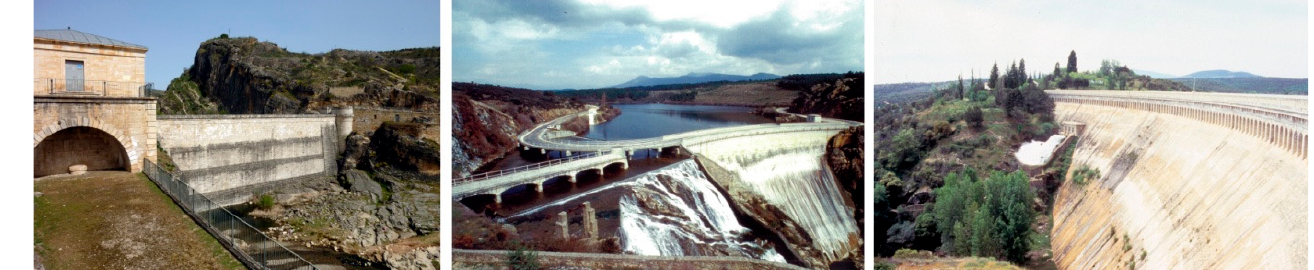
Figure 5. Pontón de La Oliva (1858–1860): straight solid masonry gravity-based dam and narrow- lipped spillway. Villar Dam (1869–1882) Engineers Elzeario Boix and José Morer: first curved grav- ity dam built worldwide with a lateral spillway system. Puentes Viejas Dam (1914–1929): curved plan gravity dam. Source: FMA.